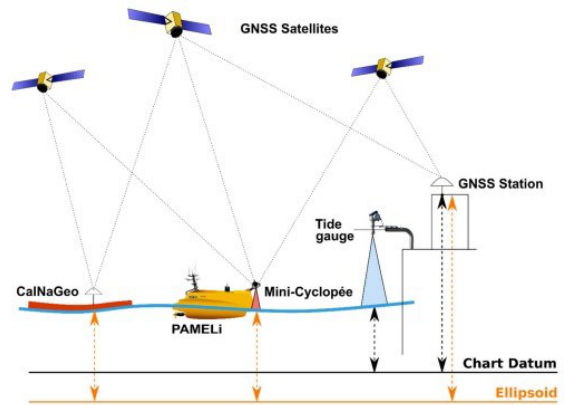
Figure 15. CalNaGeo and Cyclopée systems measuring SSHs in static tide gauge experiment [19].